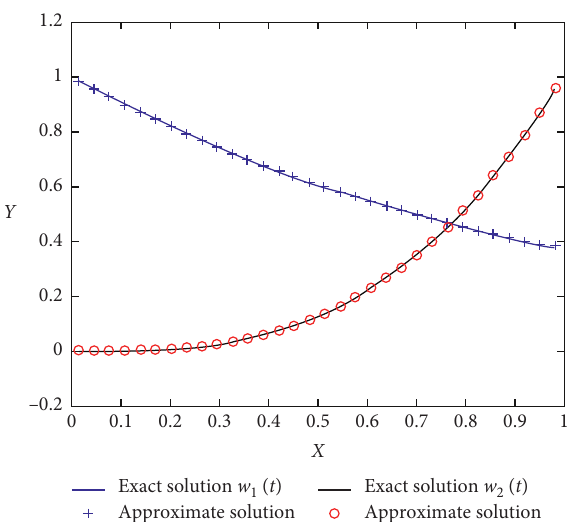
Figure 1: Comparison of exact and approximate solution for N � 32 for Problem 1.